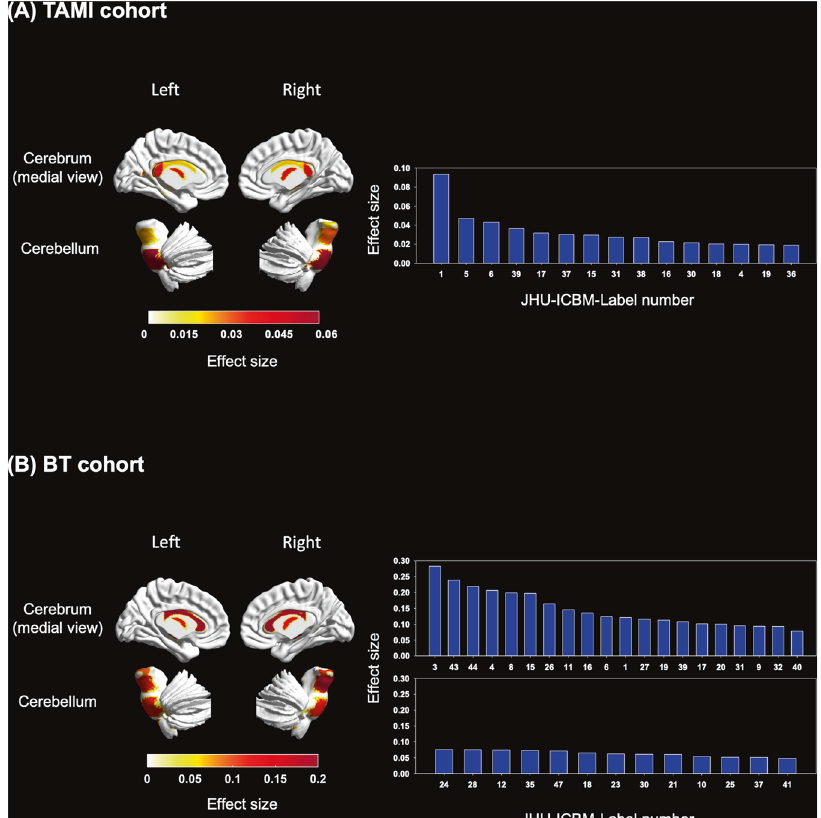
Fig. 3 Group differences in brain-age gaps between participants with schizophrenia and HCs in 48 models for FA map in the two cohorts. A Subplot A illustrates the white matter tracts with signi fi cantly accelerated aging and the effect sizes in participants with schizophrenia in the TAMI cohort. B Subplot B presents the white matter tracts with signi fi cantly accelerated aging and effect sizes in participants with schizophrenia in the BT cohort. The white matter tracts in the left panel indicate signi fi cant differences in brain age gaps after FDR correction in the TAMI and BT cohorts. The color bar represents effect size (partial η 2 ). The right panel illustrates bar charts of effect sizes (partial η 2 values) for white matter tracts with signi fi cant differences. The white matter tracts corresponding to the JHU-ICBM-Label number are presented in Supplementary Table 6. Participants with schizophrenia had signi fi cantly larger brain age gaps in 15 of the 48 models for FA map in the TAMI cohort. Moreover, 33 white matter tracts had signi fi cantly larger brain age gaps in participants with schizophrenia than in HCs in the BT cohort (see Supplementary Table 6). FA fractional anisotropy, TAMI Taiwan Aging and Mental Illness, BT Tri-Service General Hospital Beitou Branch, FDR false discovery regions [27]. Chen et al. found that cortical thickness signi fi cantly contributes to normalized predicted age differences in schizo- phrenia in the frontal lobe, bilateral precunei, middle temporal gyri, temporal poles, lateral orbitofrontal gyri, and superior parietal gyri [28]. Man et al. found that the subcortical regions and medial and lateral prefrontal cortices had the most signi fi cant negative correlations between GM volume and the brain age gap [21]. Kaufmann et al. found that among the different brain regions, the frontal lobe of individuals with schizophrenia had the most pronounced acceleration of brain aging [20]. Zhu et al. revealed that individuals with schizophrenia had signi fi cantly larger brain age gaps than those of healthy controls across different durations of illness in the brain volume and cortical thickness models [30]. Neuroimaging-based studies have indicated that GM volume abnormalities mainly occur in the insular cortex, temporal poles, middle cingulum, thalamus, and orbital part of inferior and middle frontal gyri in individuals with schizophrenia [55 – 57]. The results of a meta-analysis demonstrated that patients with schizophrenia have medium-size volume reductions in bilateral insula, particu- larly in the anterior insular subregion [58]. These structural imaging-based fi ndings were consistent with our results. These fi ndings jointly suggest that the brain age gap can effectively re fl ect schizophrenia-related deterioration in brain structure.